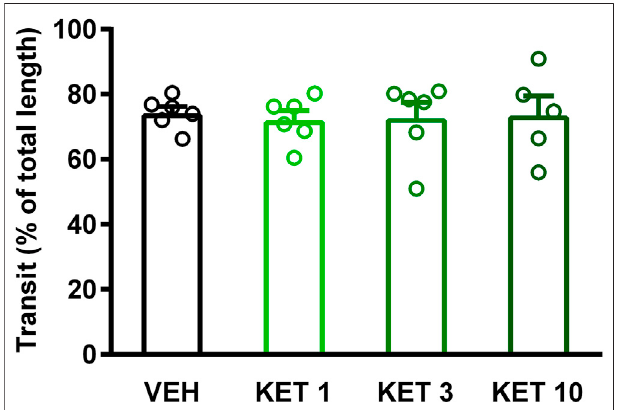
FIGURE 9 | The effect of vehicle (VEH) or ketorolac (KET) given at different doses (1, 3 and 10 mg/kg per os, once daily for fi ve days) on rat gastrointestinal transit. Circles represent the distance traveled by charcoal in each rat, bars indicate the mean + SEM. For statistical analysis one-way ANOVA with Holm-Sidak post hoc test was used, n (cid:2) 5 –